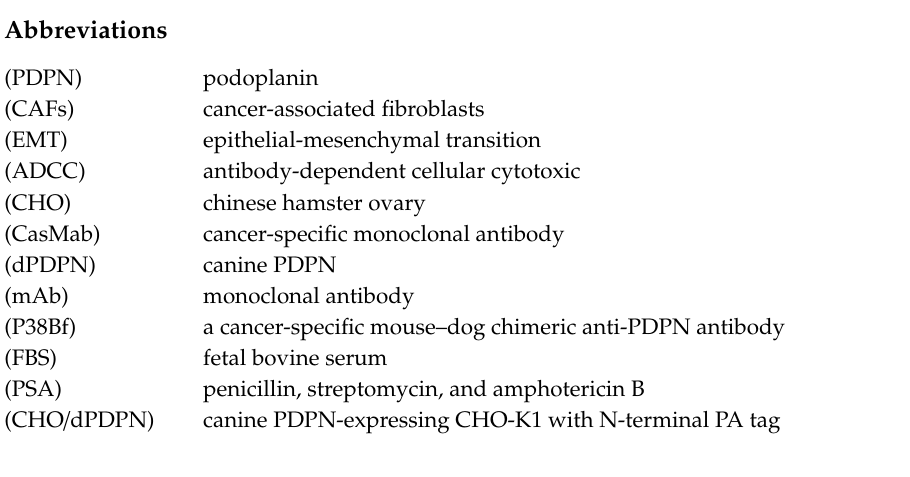
Figure S1: Evaluation of dPDPN expression on canine malignant melanoma cell lines by flow cytometric analysis; Figure S2: Kinetic of P38Bf in blood serum in one healthy dog; Figure S3: Evaluation of acute adverse e ff ects of P38Bf administration in one healthy dog; Figure S4: Evaluation of chronic adverse e ff ect of P38Bf administration in one healthy dog; Figure S5: Whole body histopathological evaluation of chronic adverse e ff ects of P38Bf administration; Figure S6: Representative images of immunohistochemistry for dPDPN in oral malignant melanomas of three cases; Figure S7: Serum CRP levels of three cases before and after administration of P38Bf; Figure S8: Radiographic evaluation of lung metastasis of Dog#1; Figure S9: Computed tomographic evaluation of the primary tumor at oral cavity of Dog#2; Table S1: Detailed results of the blood tests of one healthy dog; Video S1: Whole body computed tomographic examination at the time of pre-first P38Bf administration in one healthy dog; Video S2: Whole body computed tomographic examination at the time of post-last P38Bf administration in one healthy dog; Supplemental text file: The figure legends of supplemental figure 1 to